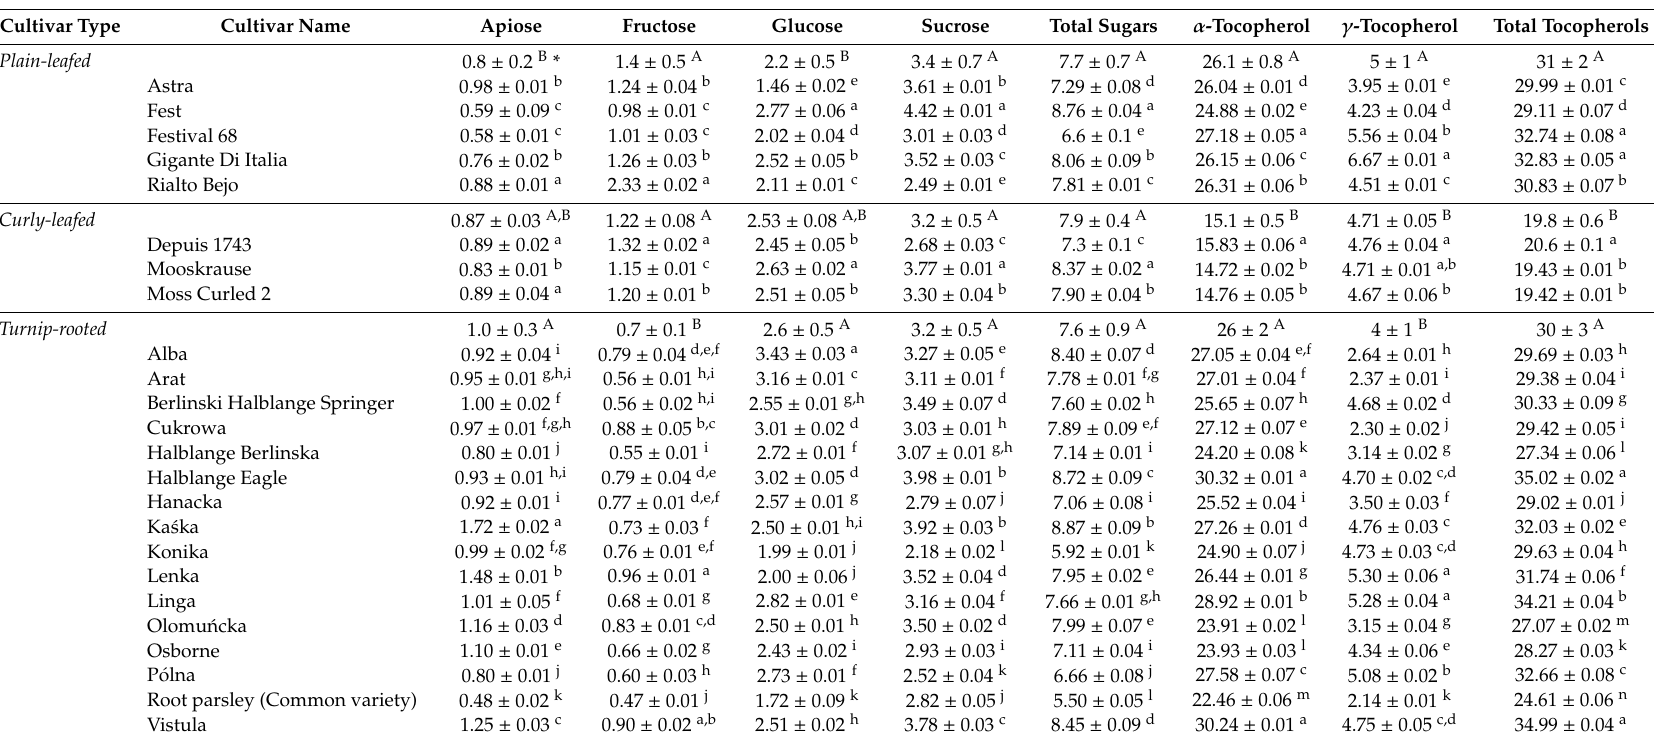
Table 4. Sugars compositions (g / 100 g dw) and tocopherols (mg / 100 g dw) composition of the studied parsley leaf samples (mean ±